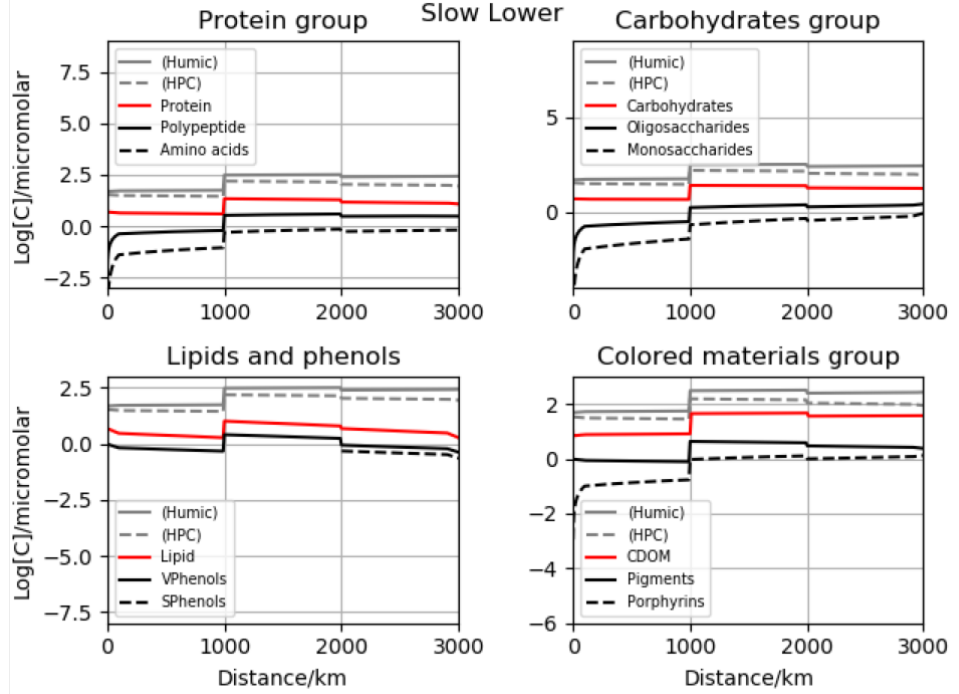
Figure 3. Time evolution corresponding to the slow lower simulation in Figure 2, but now including most of the individual organics sorted by class or biofunction. Both humics and heteropolycondensates are shown to provide an upper concentration reference in each panel. We transition to log scaling in order to capture early rapid processes.